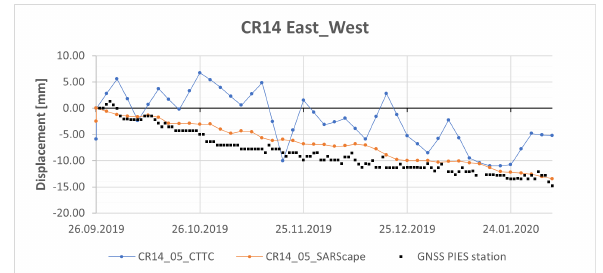
Figure 14. The CR14 horizontal displacements determined